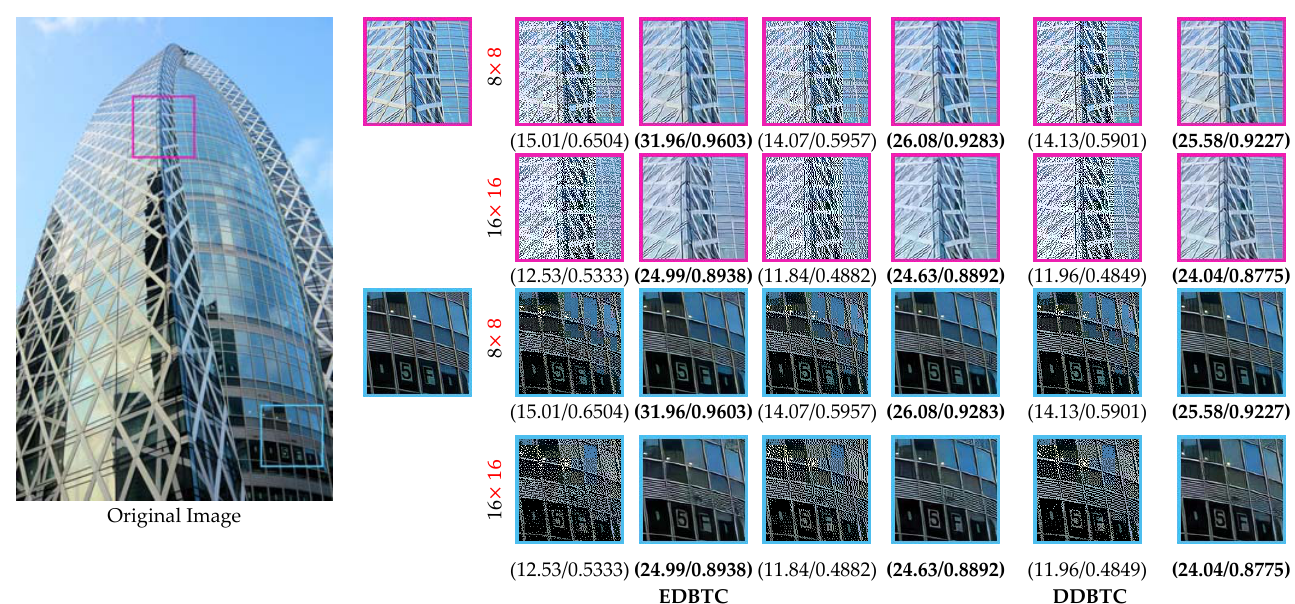
Figure 14. Performance comparisons over various H ‐ BTC methods on an image img_039 from the URBAN100 dataset.